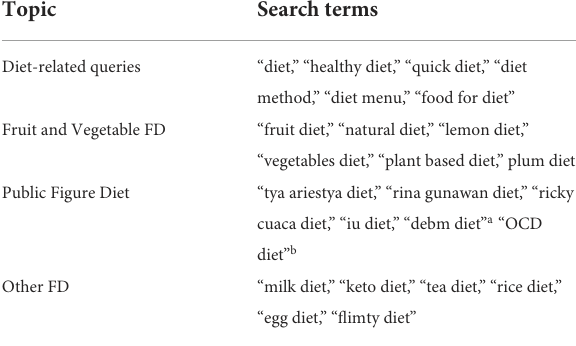
TABLE 1 Description of the diet